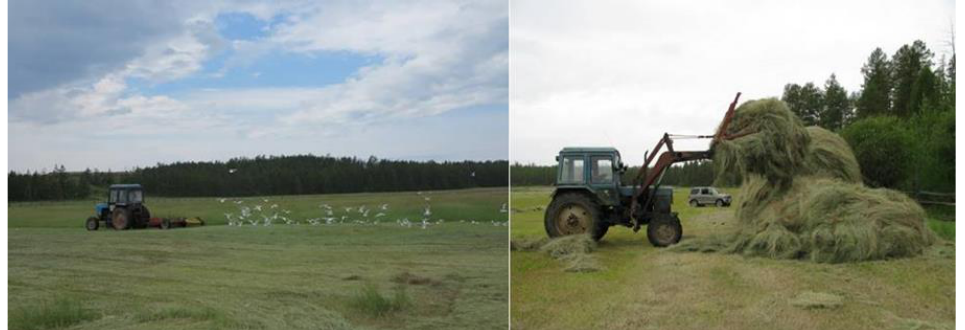
Figure 6. Hay harvesting in the alas of Central Yakutia.